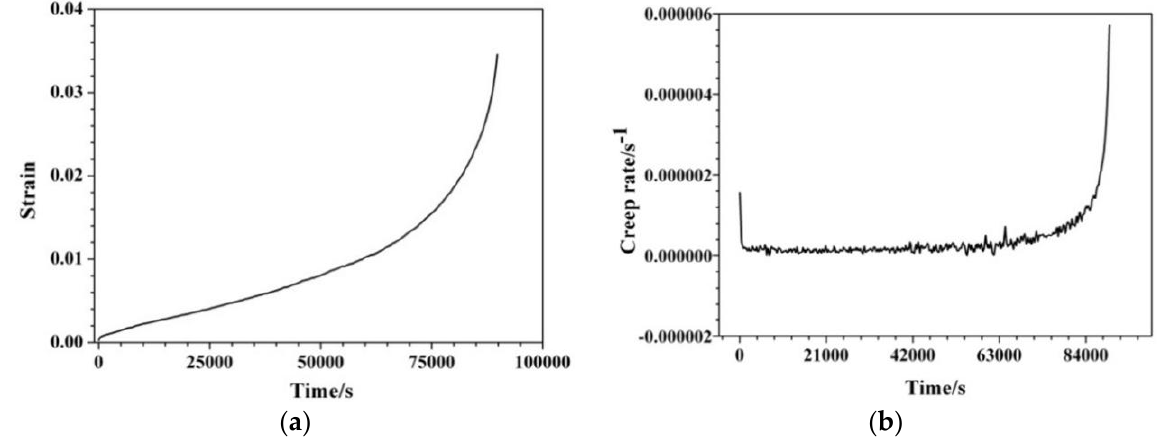
Figure 9. Typical creep curve ( a ) and creep-rate curve ( b ) of Al-Si-Cu-Ni-Mg alloy. Table 2. Part of the minimum creep rate of Al-Si-Cu-Ni-Mg alloy before and after heat exposure under different creep